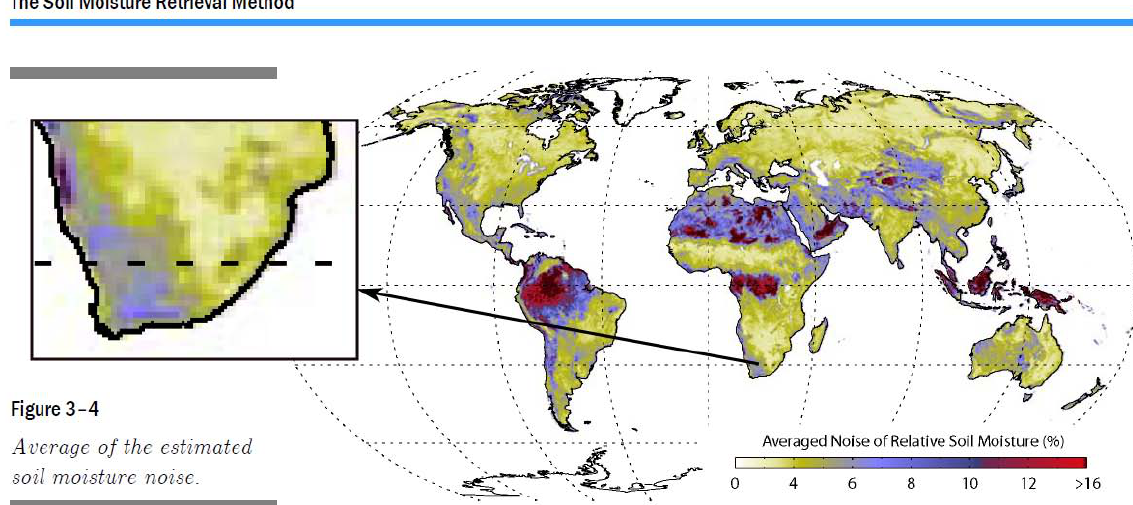
Fig. 21. Yearly average of ERS based surface soil moisture retrieval errors scaled by range. This figure is adapted from Bartalis et al. (2008). The broad patterns shown over South Africa, which are effectively a measure of the signal to noise ratio, match those shown in Fig. 17, which shows the correlation computed between ASCAT SSM and TOPKAPI